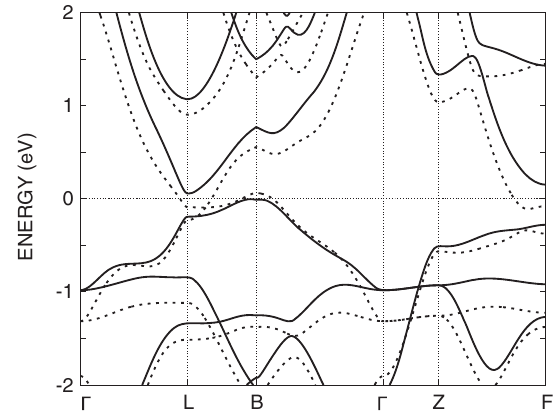
FIG. 6. Electronic band structure of Y 2 C in the GWA. Elec- tronic band structures of Y 2 C in the GWA and the LDA. The solid line and the dotted line show the results in GWA and those in LDA, respectively. The energy is measured from the Fermi level.